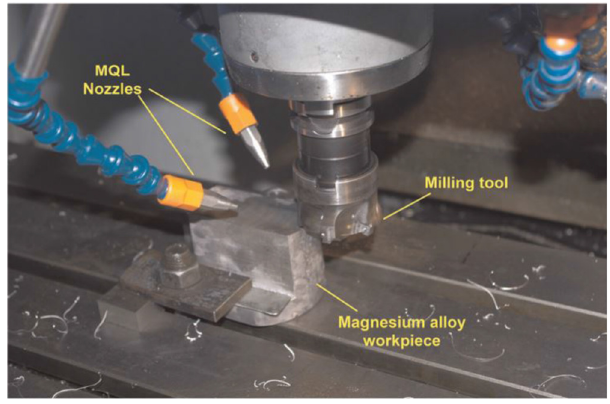
Fig. 7. Experiment set-up [31].